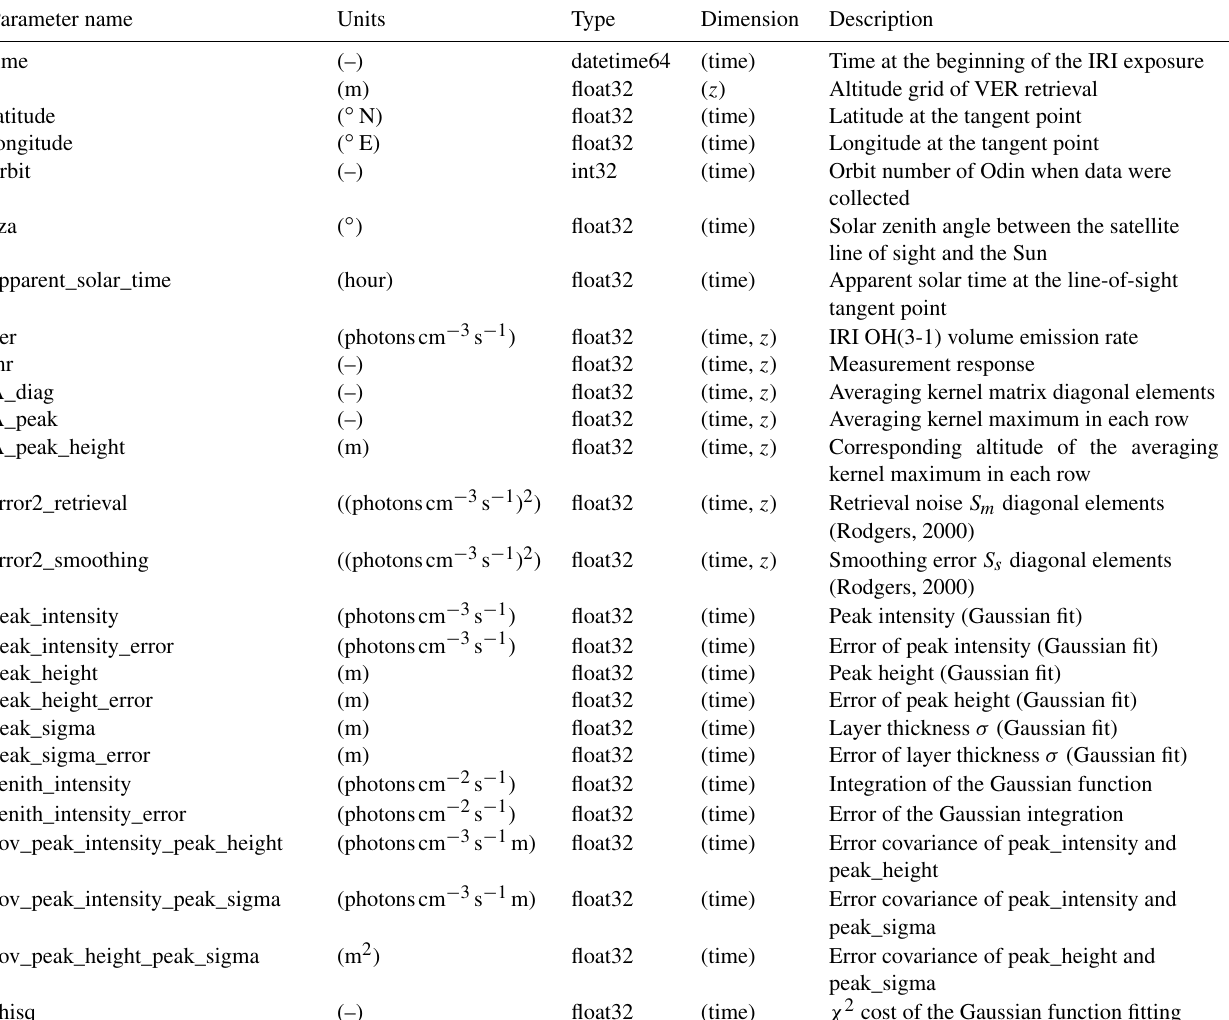
Table 2. Parameters included in the “iri_ch1_ver_(year).nc” files, where “(year)” should be replaced by a four-digit number representing the